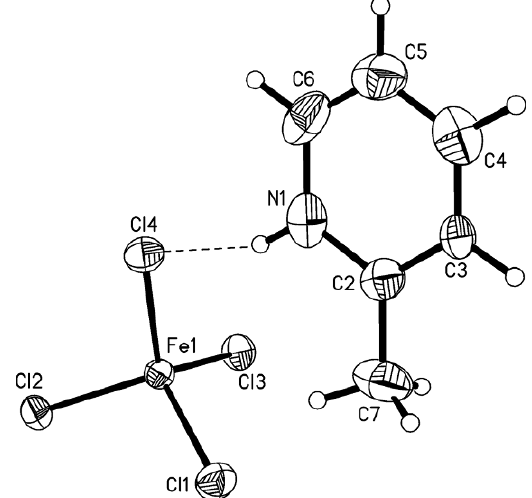
Figure 1. The molecular structure of [2-Me(Py)H][FeCl the atom-labeling scheme. The N–H … Cl hydrogen bond is represented by dashed lines. The displacement ellipsoids are drawn at the 25% probability level, and H atoms are shown as small spheres of arbitrary Table 2. Hydrogen-bond geometry /Å, /° for [2-Me(Py)H][FeCl